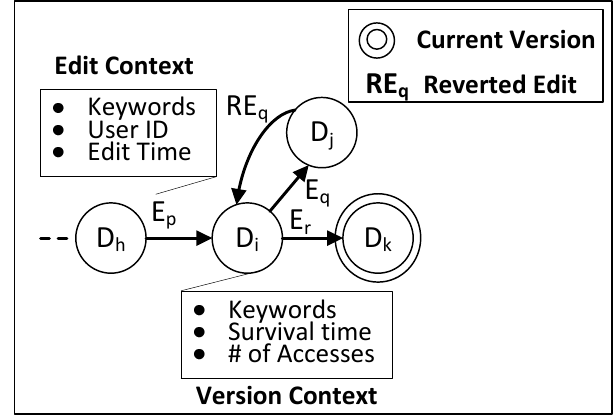
Figure 3. Context-Enhanced FSM for